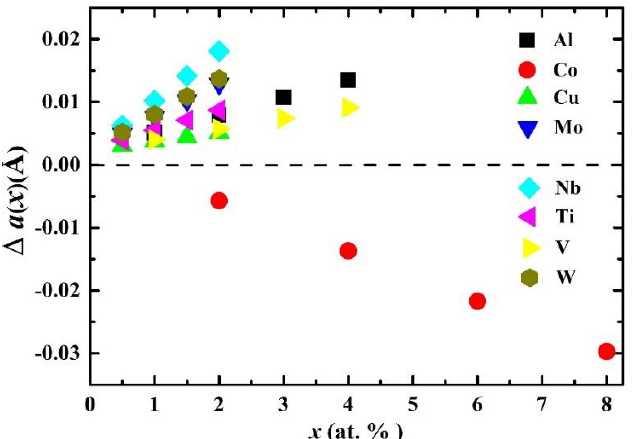
Figure 2. Changes in the equilibrium lattice parameters ( a ( x )), based on Equation (7), of paramagnetic fcc Fe 0.6 − x Cr 0.2 Ni 0.2 M x (where M = Al, Co, Cu, Mo, Nb, Ti, V, and W; 0 ≤ x ≤ 0.08) quaternary alloys relative to the paramagnetic fcc Fe 0.6 Cr 0.2 Ni 0.2 ternary alloy as a function of atomic concentration x .